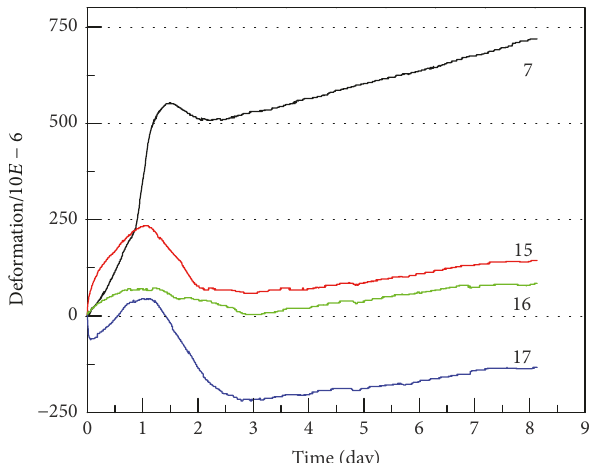
Figure 12: The autogenous shrinkage of references with SRA and SRA-SCA.